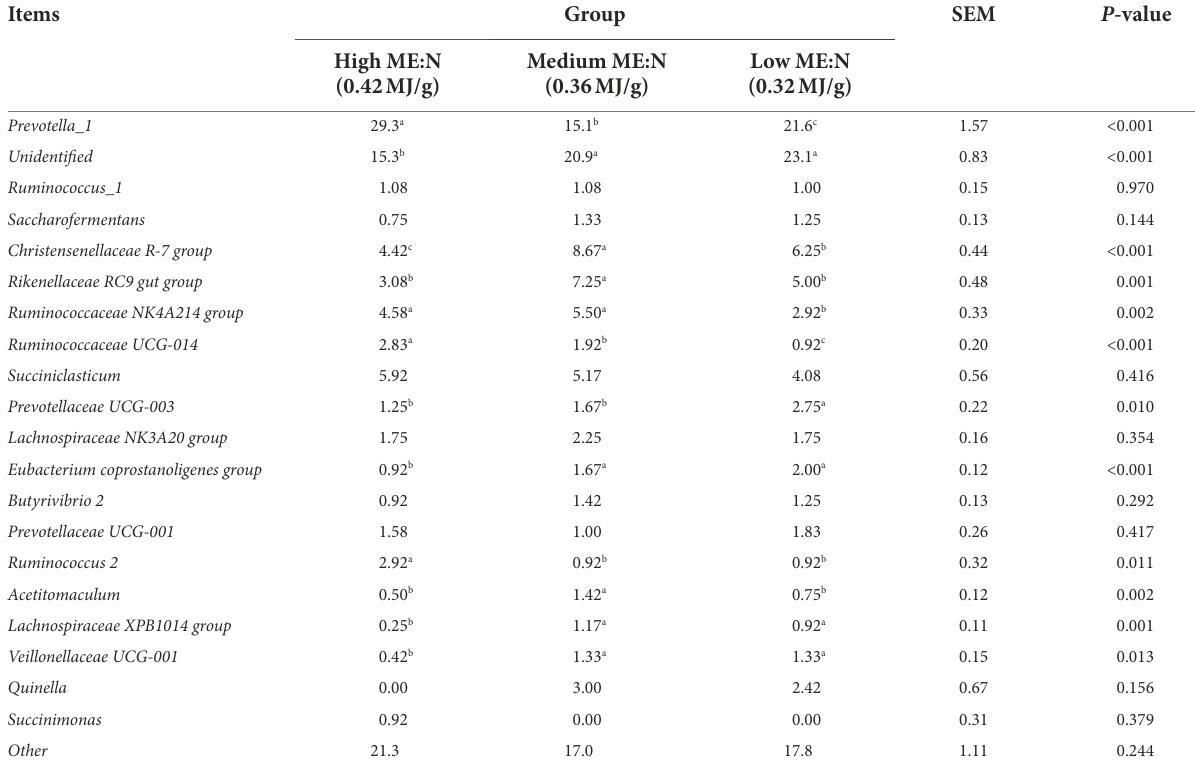
TABLE 6 Effect of the ME:N ratio on the top 20 bacterial genera in yak rumen fluid.